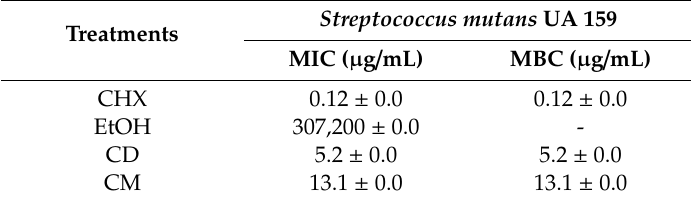
Table 2. Minimum inhibitory concentration (MIC) and minimum bactericidal concentration (MBC) of chitosan dispersion (CD) and chitosan microparticles (CM) against S. mutans planktonic cells.